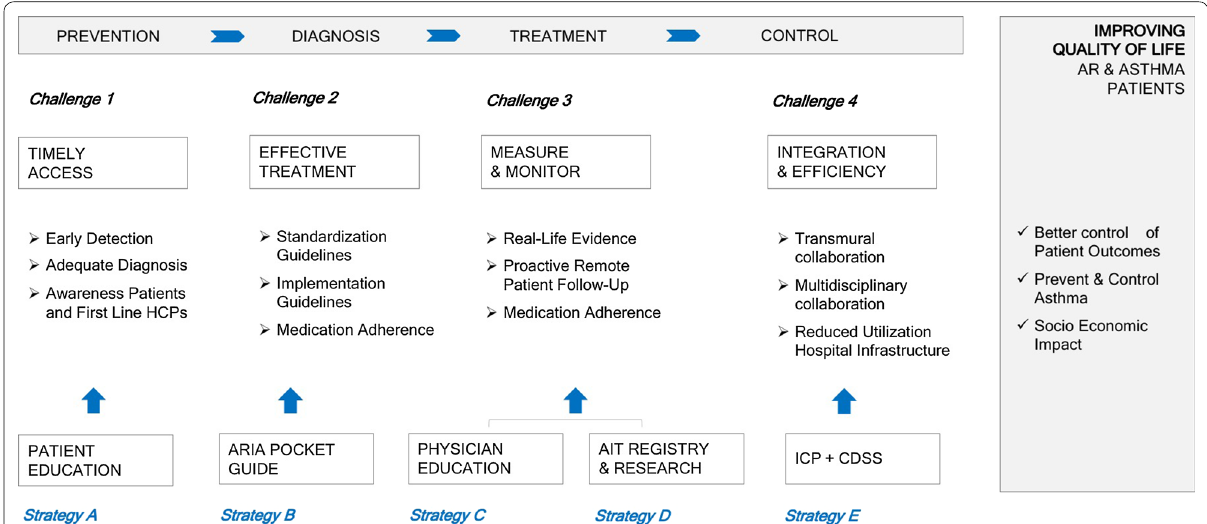
Fig. 2 Overcoming real‑life barriers for AIT adoption. AR: allergic rhinitis, CDSS: clinical decision support system, HCPs: health care professionals, ICP: integrated care